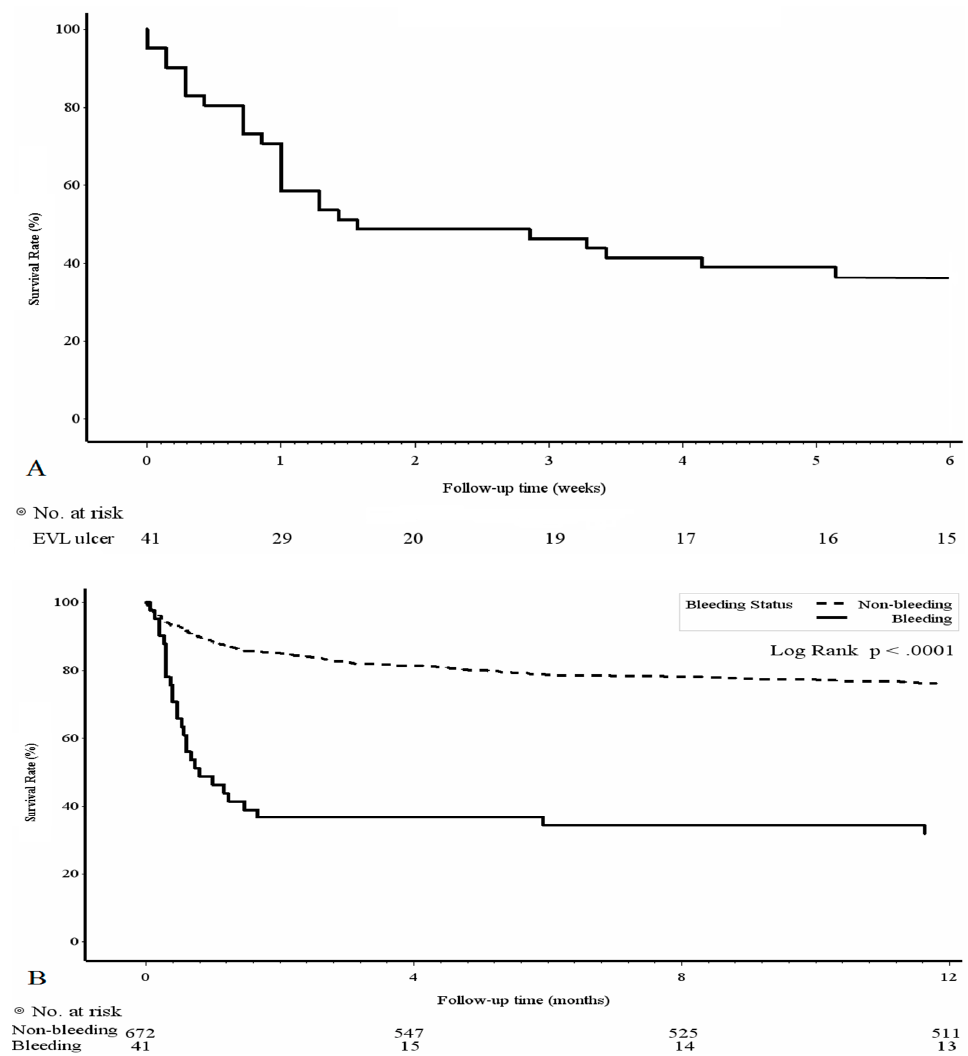
Figure 1. ( A ) Survival rate of PBUB group within 6 weeks; ( B ) Kaplan-Meier survival curves with a log-rank test between PBUB and non-PBUB groups within 1 year.